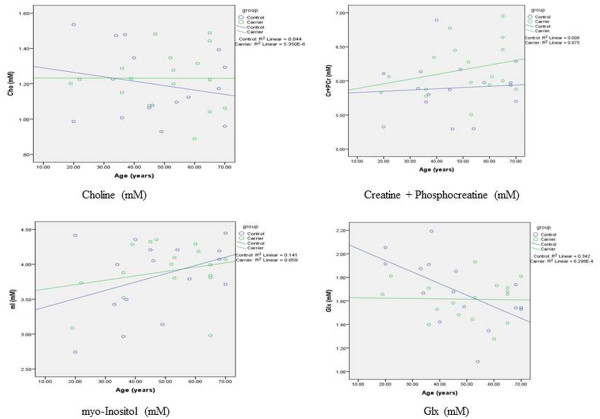
Correlation between Cho, Cr + PCr, mI and Glx measured in the right parietal and age in premutation Frax Carriers and Controls.